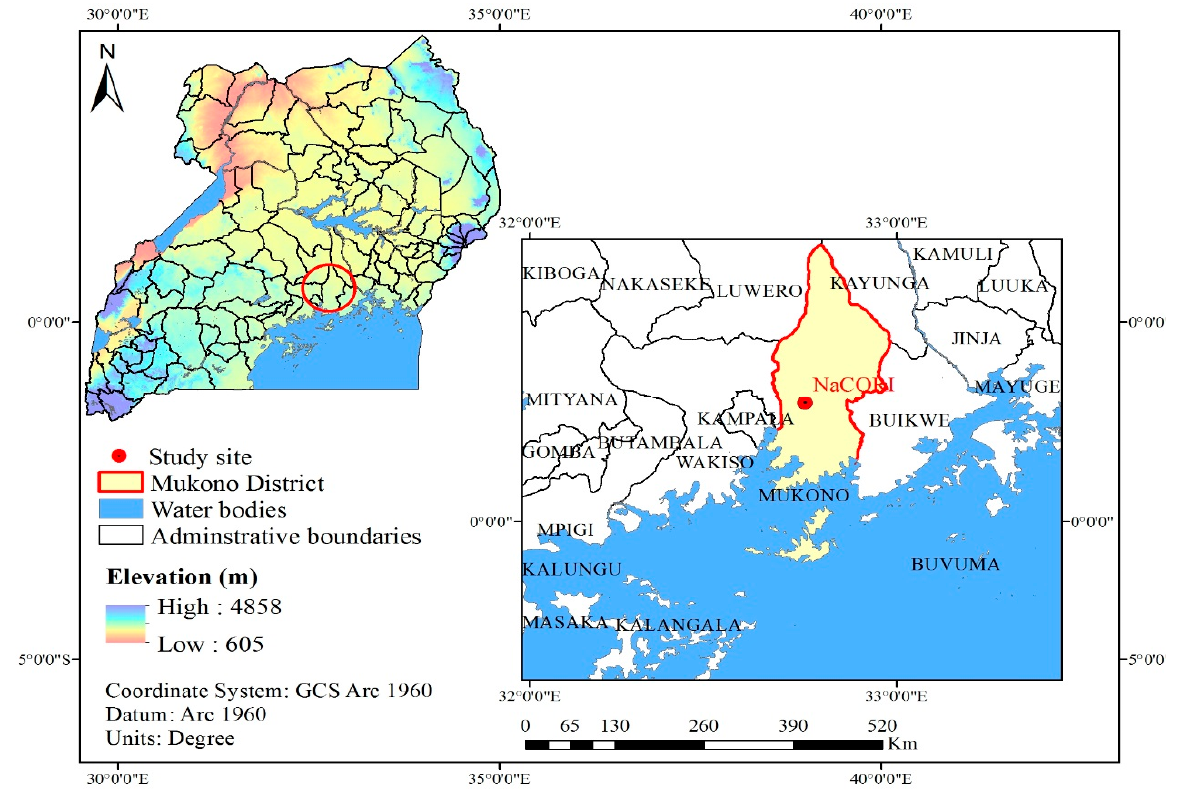
Figure 1. Study site in the Mukono district, Central Uganda. The map was drawn using QGIS 3.6.